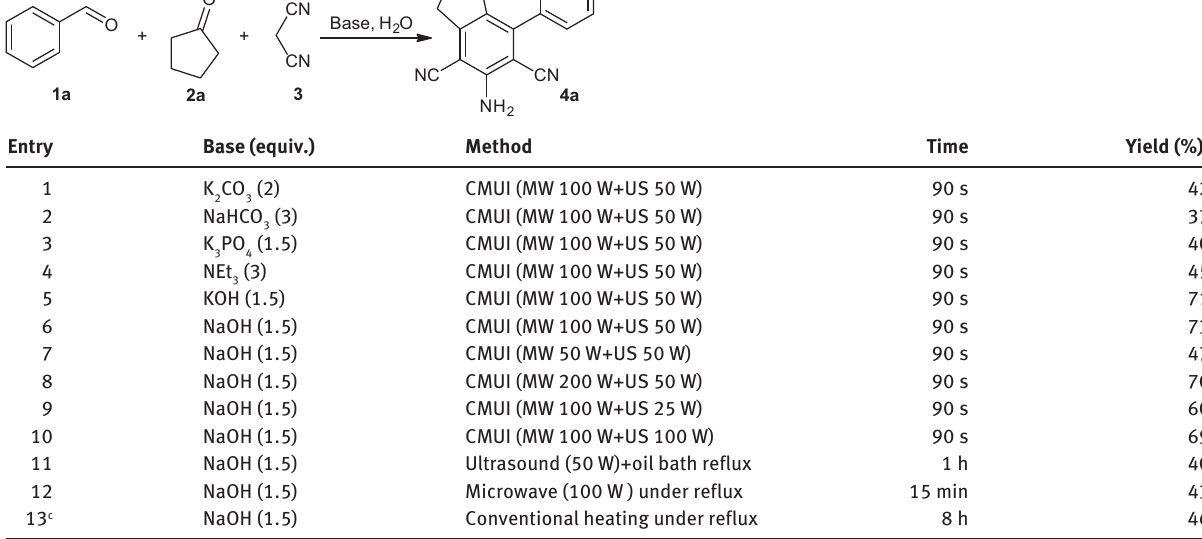
Table 1 Optimization of base in the synthesis of compound 4a. a a Reactions were performed under reflux using benzaldehyde (2.0 mmol), cyclopentanone (2.0 mmol), malononitriles (4.4 mmol), base and water (5 ml). b Isolated yields. c Solvent: CH